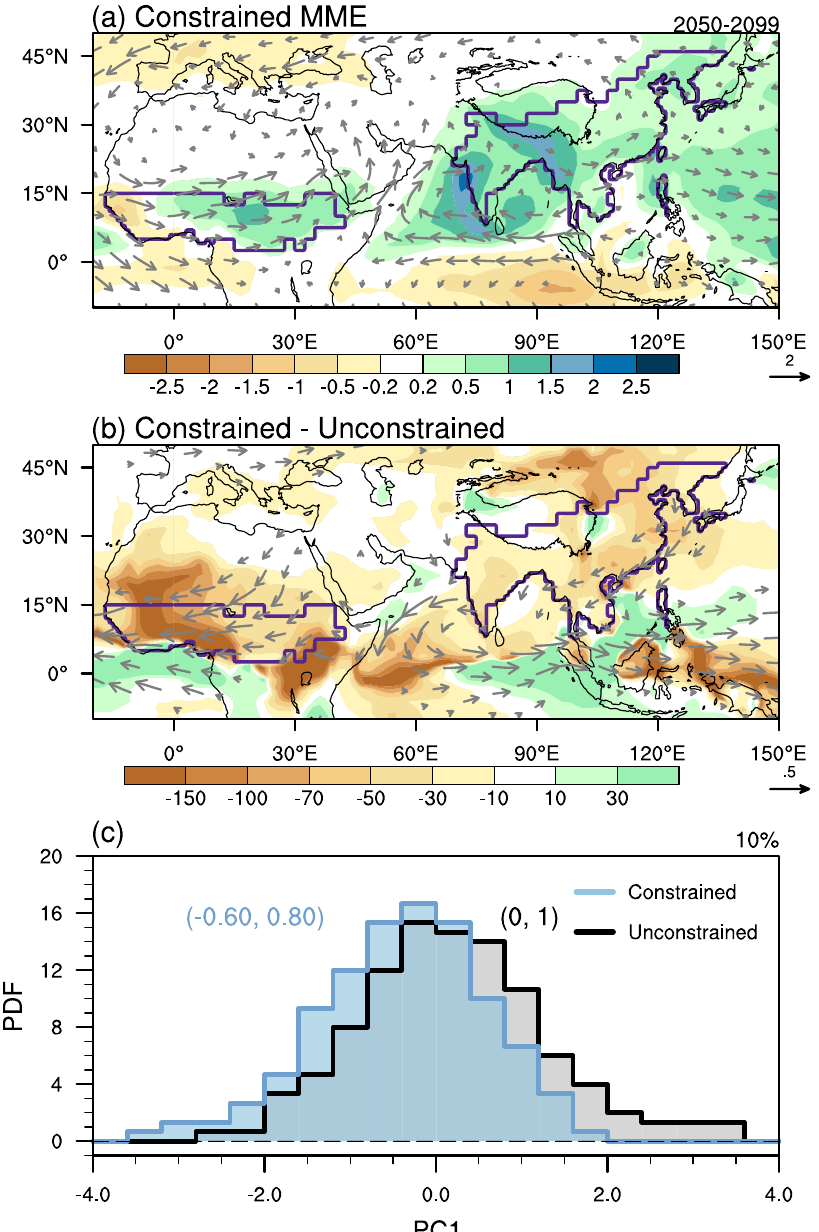
Fig. 5 The constrained projection and narrowed uncertainty of Afro-Asian summer monsoon precipitation. a The constrained precipitation (shading, mm day − 1 ) and wind at 850 hPa (UV850; vector, m s − 1 ; vectors drawn for larger than 0.1 m s − 1 ) based on the reconstruction of observed PC1, and ( b ) the constrained effect represented by the difference between constrained and unconstrained multi-model ensemble (MME). The constrained effect of precipitation in b is represented by the percentage (%) relative to the absolute values of unconstrained MME. Before calculating the fraction of constrained effect in b , the unconstrained MME are set as 0.05 mm day − 1 over the regions where the absolute values of unconstrained MME are lower than 0.05 mm day − 1 . c Probability distribution function (PDF) of unconstrained (black) and constrained (blue) PC1. The values on the right corner are the narrowed variance due to emergent constraint. The values in the parenthesis are the mean and the standard